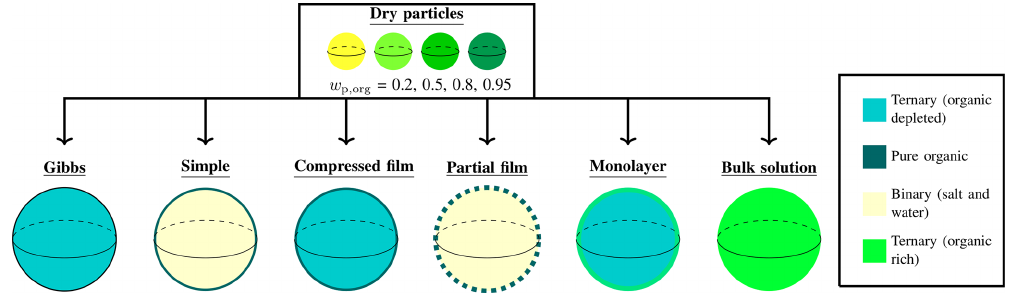
Figure 1. A conceptual figure of the different models. The figure shows the initial dry particles at a range of compositions (represented by the different colors of the particles), and the different models used to predict droplet critical properties. The different models are described at some point of droplet growth before activation, with the different colors of the droplet bulks or surfaces indicating differences in composition (dark turquoise for ternary mixture where the organic component is significantly depleted, dark green for pure organic substance, pale yellow for binary mixture of water and salt and bright green for ternary mixture rich in the organic